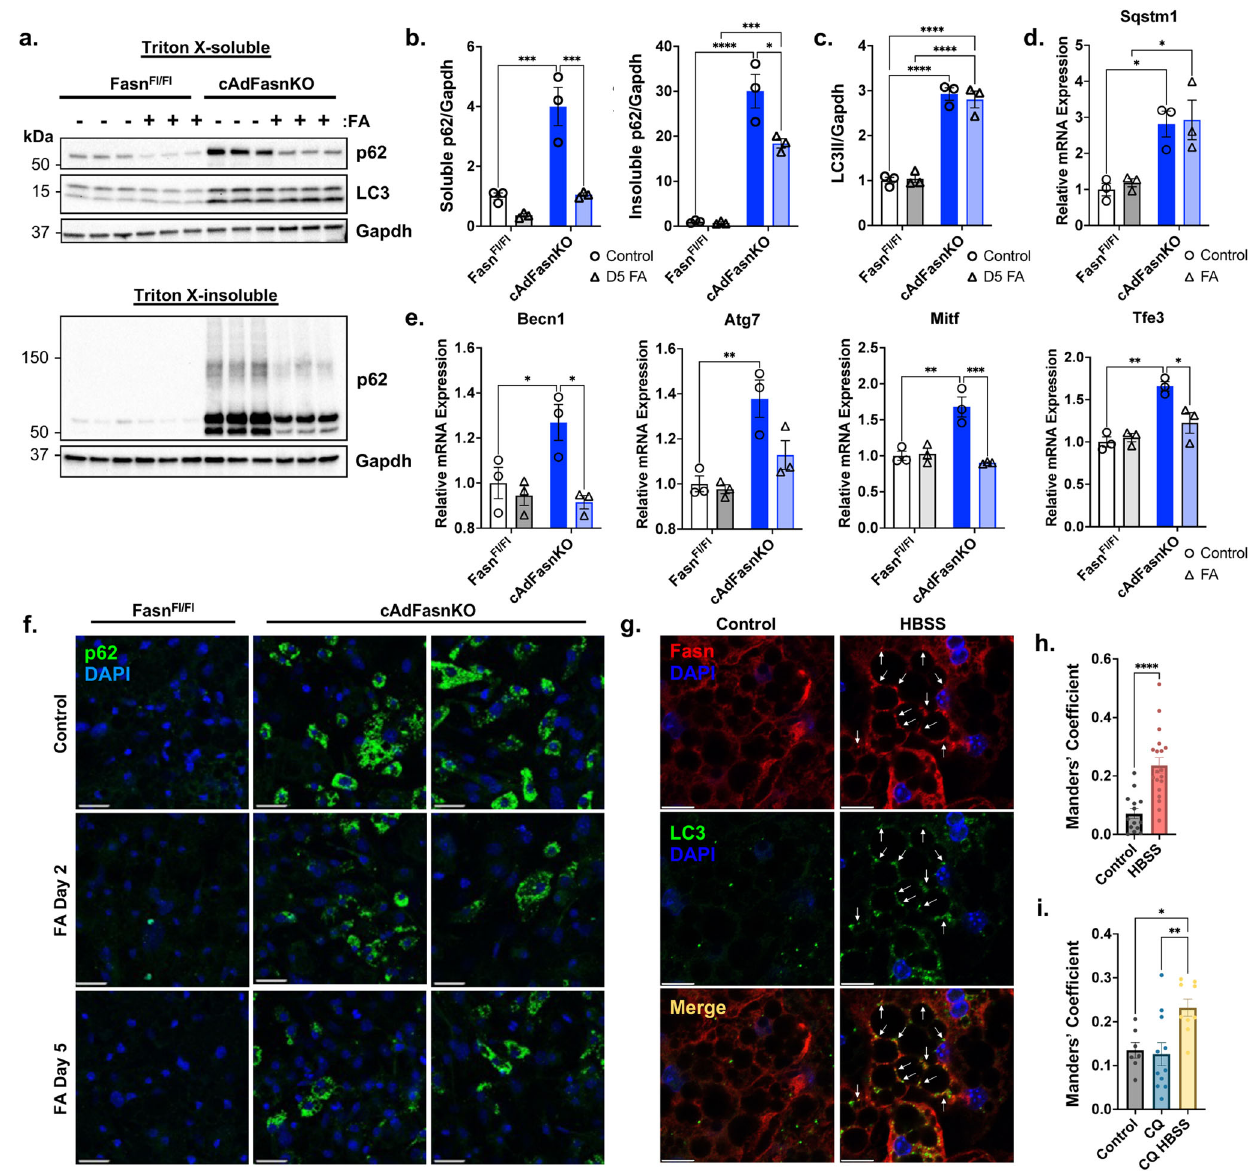
Fig. 3 | Fatty acids produced by Fasn are essential for autophagy. Fasn Fl/Fl and cAdFasnKO adipocytes were supplemented with 200 μ M each of palmitate and oleatefor48haftertheywerefullydifferentiated(day5). a WesternblotsofTriton X-100-soluble and -insoluble protein fractions. b Quanti fi cation of soluble and insolublep62 in Fig. 3Anormalized to Gapdh. c Quanti fi cation of LC3II normalized to Gapdh from Fig. 3A. d qPCR of Sqstm1/ p62 and ( e ) autophagy-related genes in adipocytes supplemented with fatty acids (FAs) throughout differentiation, beginning on day 0. n =3 samples, similar data obtained in at least 2 independent experiments. ( b – e ) All data are means±SE. All datasets ( b – e ) analyzed with two- wayANOVAwithTukeyposthoc: P values=(B,solublep62)Fasn Fl/Fl vs.cAdFasnKO 0.0009, Fasn Fl/Fl vs. Fasn Fl/Fl FA 0.5464, Fasn Fl/Fl FA vs. cAdFasnKO FA 0.4807, cAd- FasnKO vs. cAdFasnKO FA 0.0010, ( b , insoluble p62) Fasn Fl/Fl vs. cAdFasnKO <0.0001, Fasn Fl/Fl vs. Fasn Fl/Fl FA 0.9998, Fasn Fl/Fl FA vs. cAdFasnKO FA 0.0010, cAdFasnKO vs. cAdFasnKO FA 0.0122, ( c ) Fasn Fl/Fl vs. cAdFasnKO <0.0001, Fasn Fl/Fl vs. Fasn Fl/Fl FA 0.9948, Fasn Fl/Fl FA vs. cAdFasnKO FA<0.0001, cAdFasnKO vs.